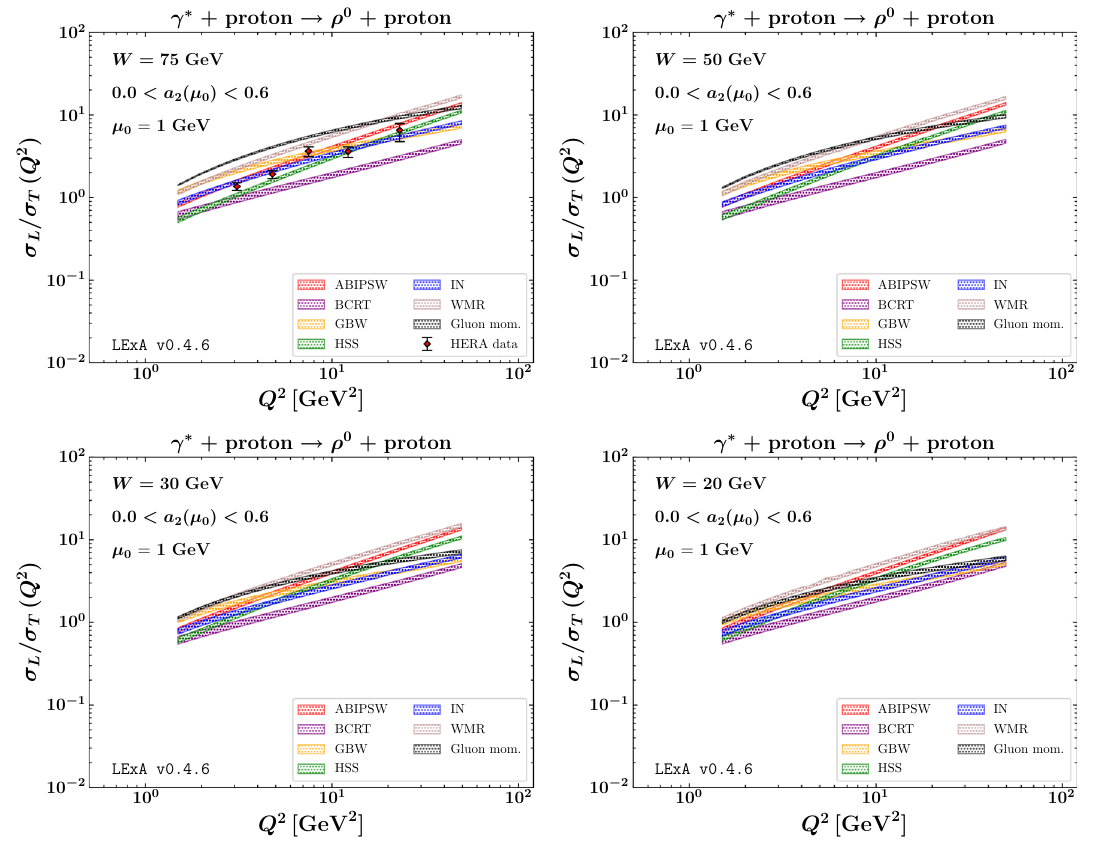
Fig. 5 Q 2 -dependence of the polarized cross-section ratio, σ L /σ T , for all the considered UGD models, at W = 75 GeV together with the HERA data(leftupperpanel)andat W = 20 , 30 , 50 GeVforEIC(theremainingpanels).Uncertaintybandsrepresenttheeffectofvarying a 2 (μ 0 = 1GeV ) between 0 . 0 and 0 .